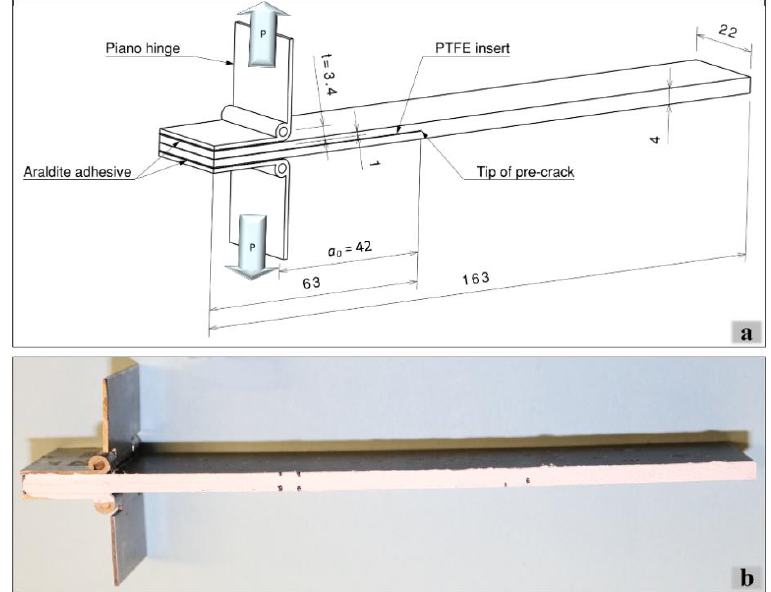
Figure 3. Double Cantilever Beam (DCB) specimen: ( a ) configuration and dimensions, ( b ) final test specimen.